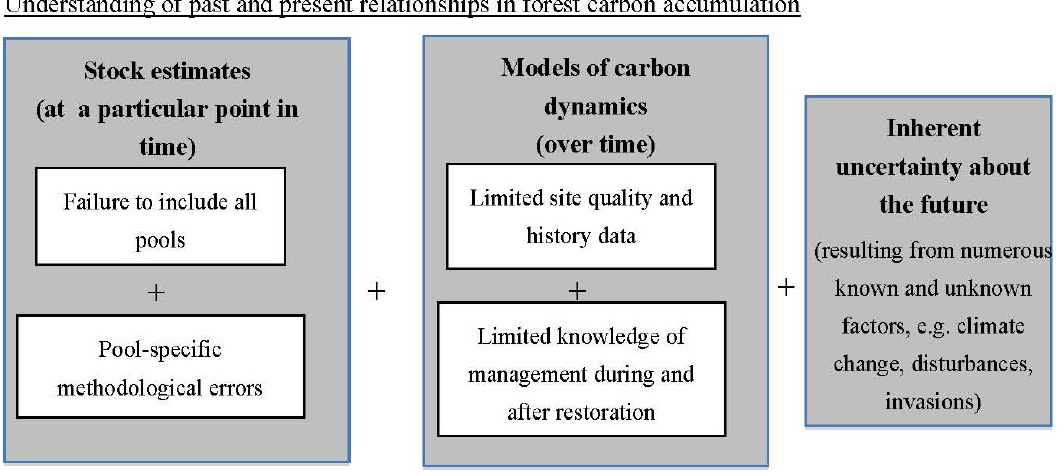
Figure 2. Sources of uncertainty in estimates of forest carbon sequestration.